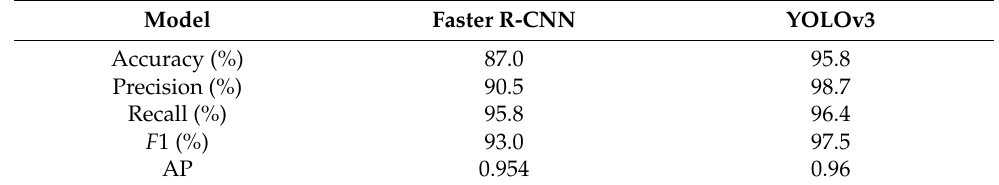
Table 3. Comparison of the two models.